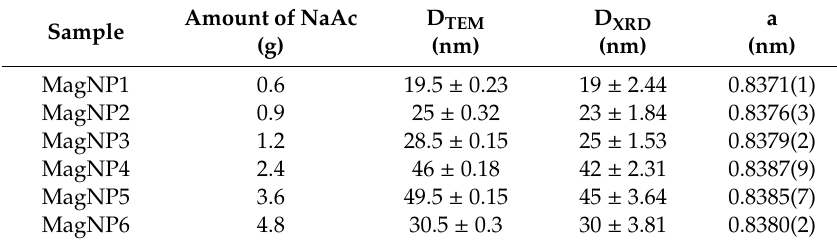
Table 1. Structural information on